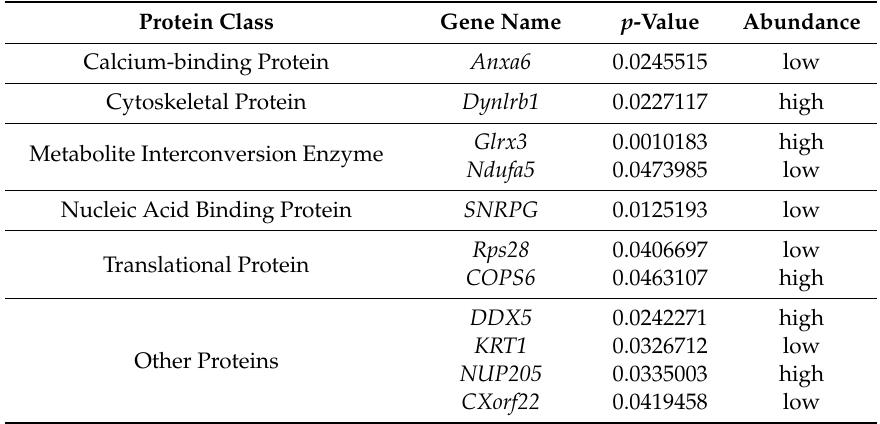
Table 3. List of 11 retinal proteins which significantly di ff erentially expressed in H 2 S treated group comparing to the CTRL group. Proteins were classified into di ff erent categories by PANTHER classification